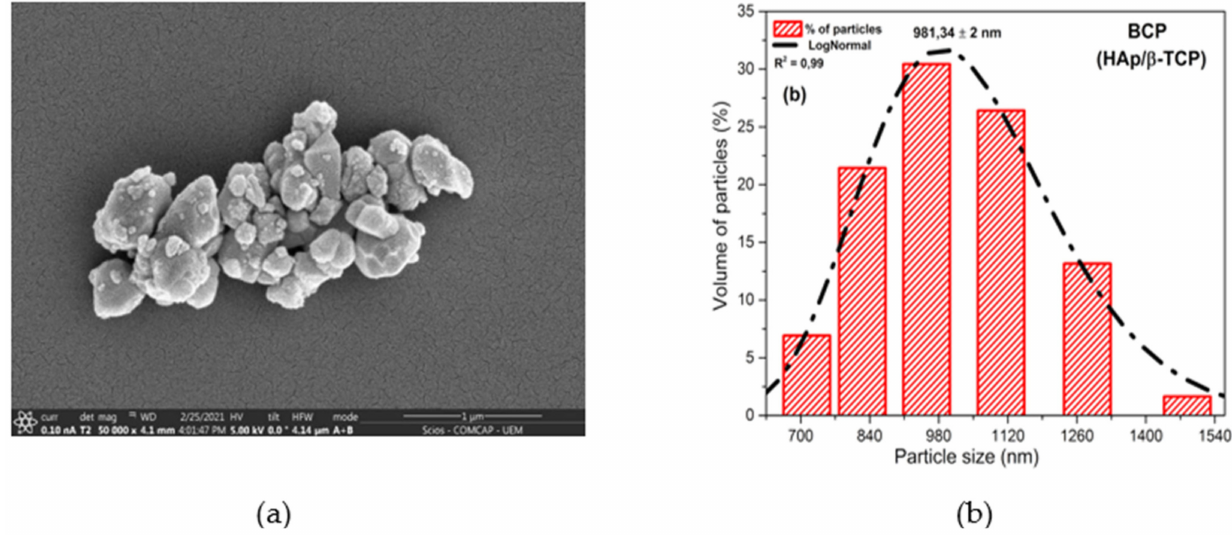
Figure 1. Morphology and particle size of BCP powder obtained by calcination fish bones at 900 ◦ C for 8 h and milled in air atmosphere in a power mill for 4h at 300 r.p.m.: ( a ) SEM showing par- ticle shape and size; ( b ) histogram relating frequency and particle size. R 2 = Adjusted R-Square; BCP = biphasic calcium phosphate; HAp = hydroxyapatite; β -TCP = β -tricalcium